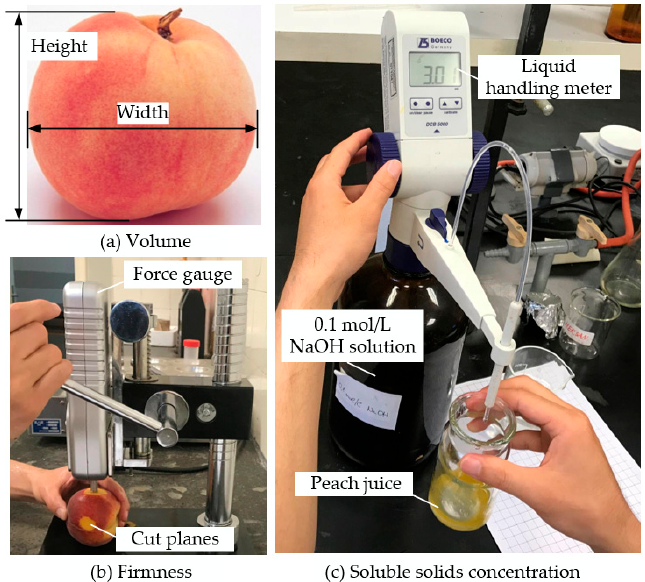
Figure 1. Volume, firmness, and titratable acidity measurement of peaches.